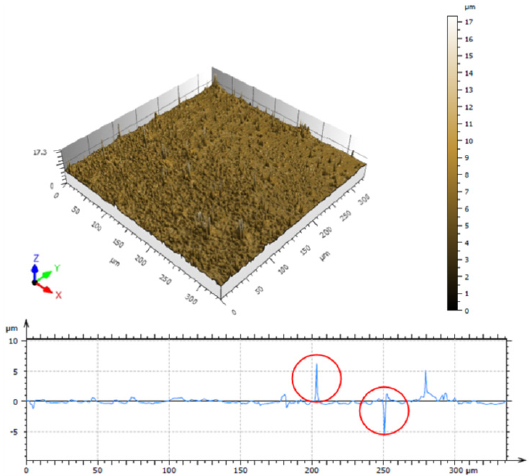
Figure 5. Best absorptance result, Film 5.